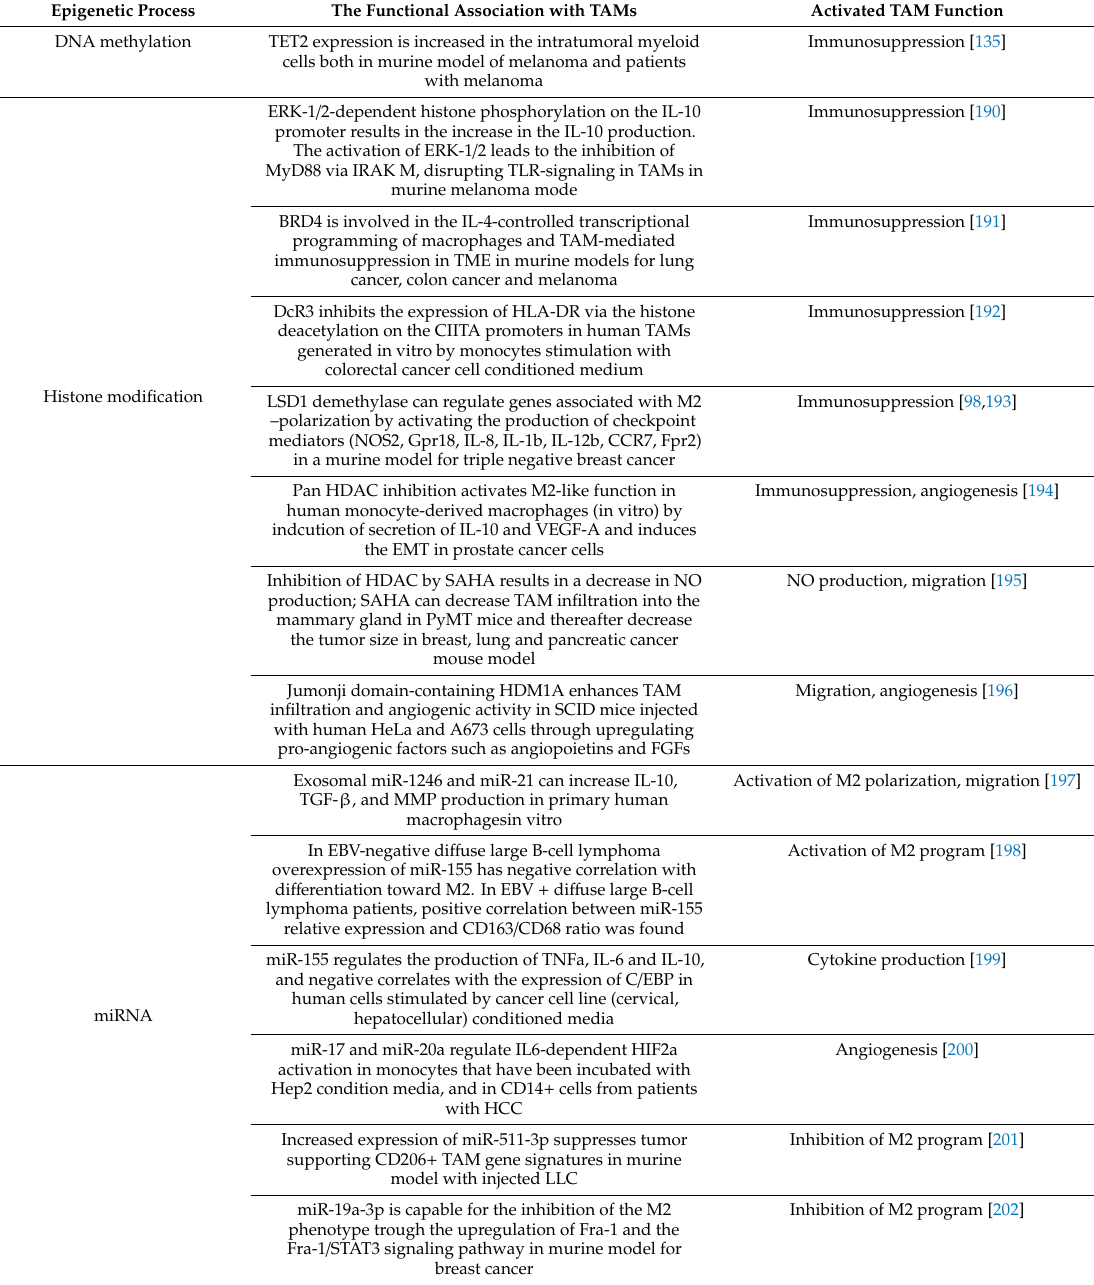
Table 3. Mechanisms of epigenetic regulation in tumor-associated macrophages